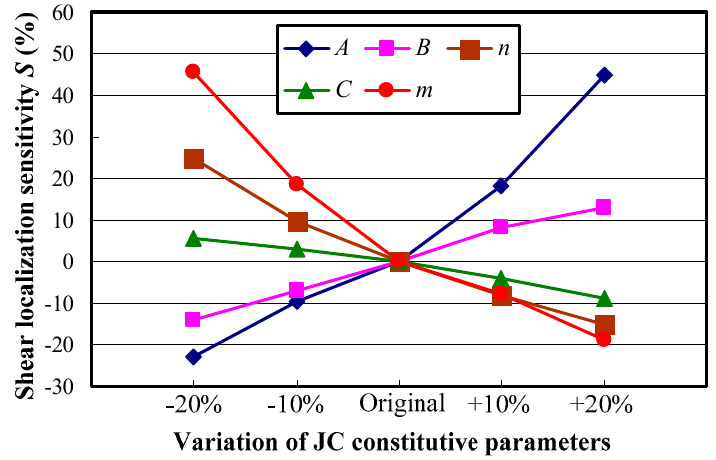
Figure 10. Influences of material constitutive parameters on chip shear localization for Inconel 718.